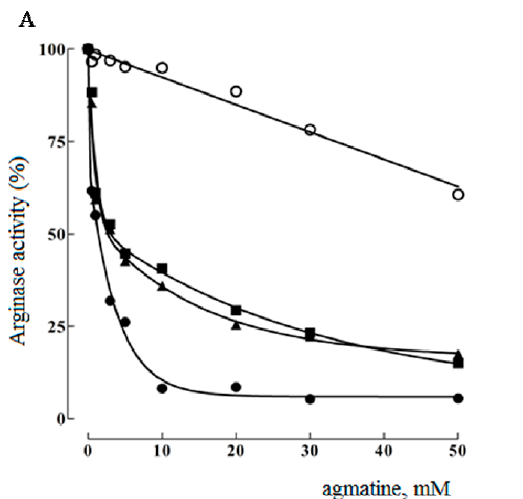
Figure 3. ( A ). Inhibition of arginase activity by agmatine, of the wild species ( ○ ) and the mutant species N130D ( ● ), S137C ( ▲ ), and N139D ( ■ ) of human hepatic arginase. A concentration of arginine of 5 mM was used and the inhibitions were carried out at pH 9.5. The detection of arginase activity was made following the production of ornithine by the method of Chinard [32]. ( B ). Effect of dialysis against EDTA on the catalytic activity of wild-type and mutant N130D species of human liver arginase. The catalytic activity of the dialyzed species was measured at 37 °C for 10 min, in the absence (white bars) and in the presence of Mn 2+ 2 mM (black bars).